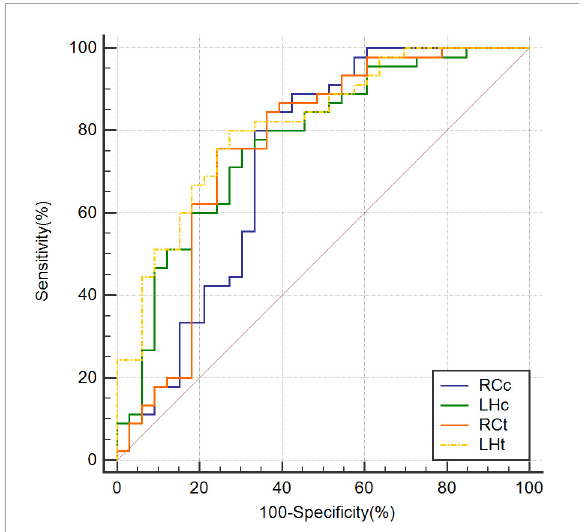
FIGURE3 Receiver operating characteristic curves based on CBF of RCc, CBF of LHc, T1 value of RCt, and T1 value of LHt, respectively. CBF, cerebral blood flow; LHc, left hippocampus; LHt, left hippocampus; ROC, receiver operating characteristic; RCc, right caudate nucleus; RCt, right caudate nucleus.